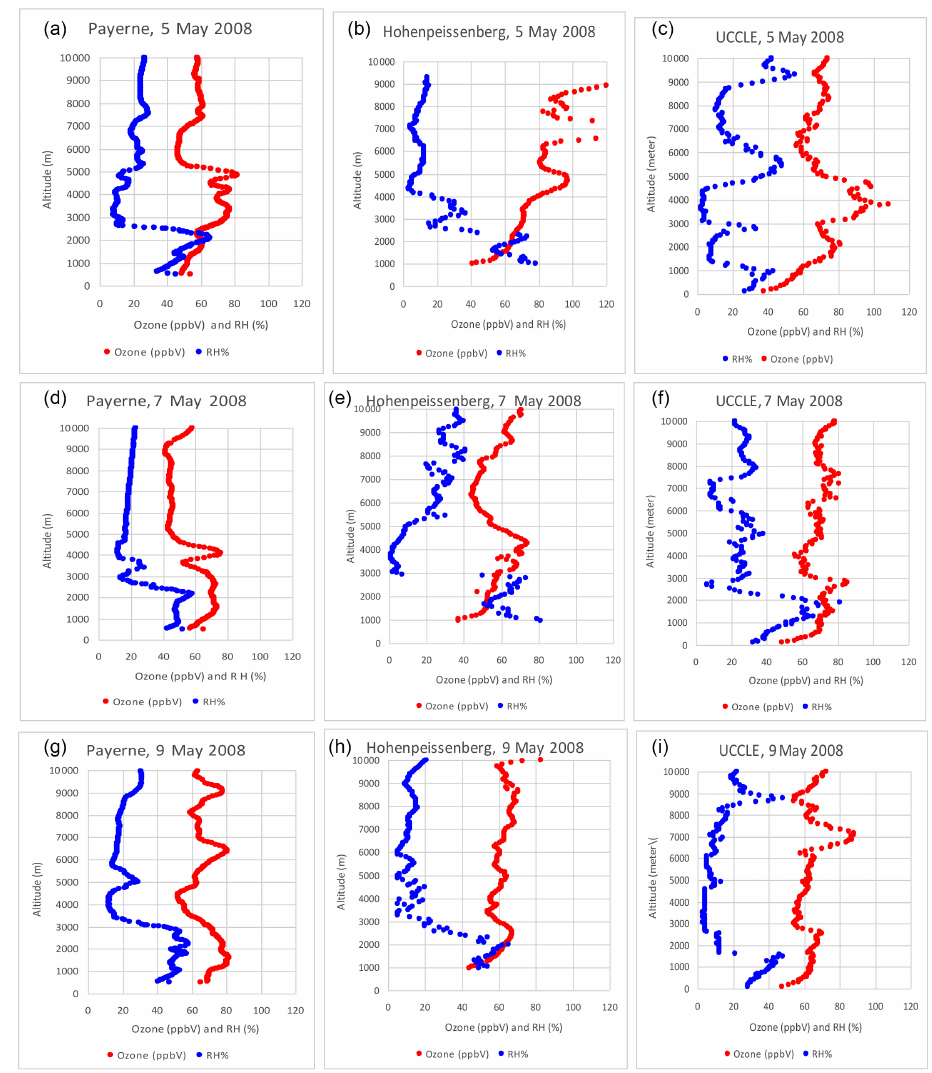
Figure 12. Vertical profiles of ozone (red; ppb) and relative humidity (blue; %) over Payerne, Switzerland (left column), Hohenpeissenberg, Germany (middle column), and Uccle, Belgium (right column), on 5 May 2008 (a, b, c) , 7 May 2008 (d, e, f) and 9 May 2008 (g, h, i)